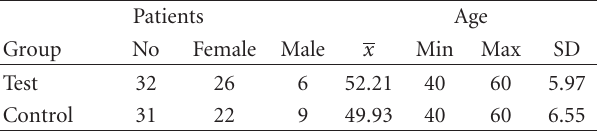
Table 1: Basic characteristic of patients in both